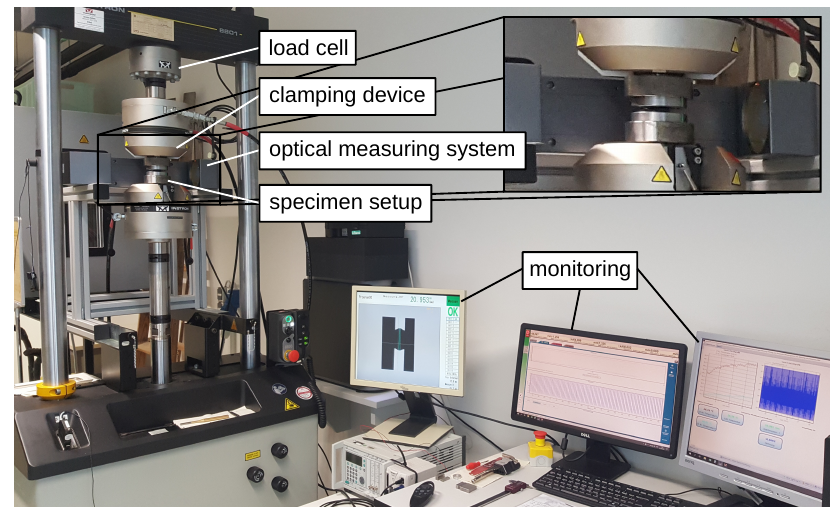
Figure 4. Test rig for lifetime investigations of technical rubber